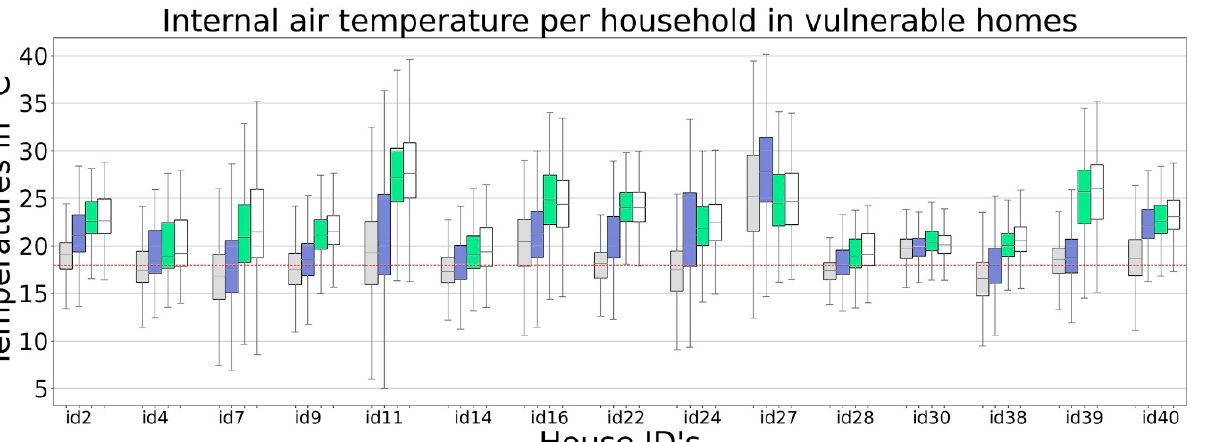
Figure 10. Number of underheating days per home split monthly according to criterion 2.